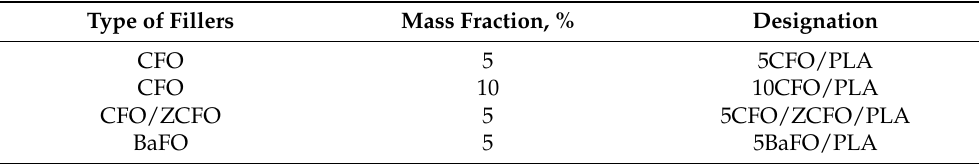
Table 1. Types and concentrations of magnetic particle fillers in composite